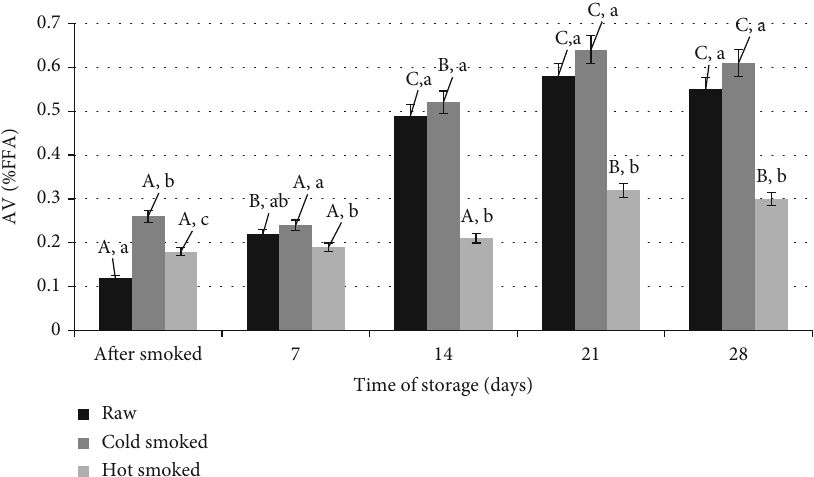
Figure 4: Comparison of changes in acid number during storage of raw, cold-smoked, and hot-smoked salmon. a, b, c: signi fi cant di ff erences ( n = 3 ) between individual treatments within one storage time. A, B, C: signi fi cant di ff erences ( n = 3 ) between treatments during storage. Table 2: Changes in the sum of EPA and DHA acids (mg/1 g fat) of raw, cold-smoked, and hot-smoked salmon, stored for 28 days in refrigerated conditions.